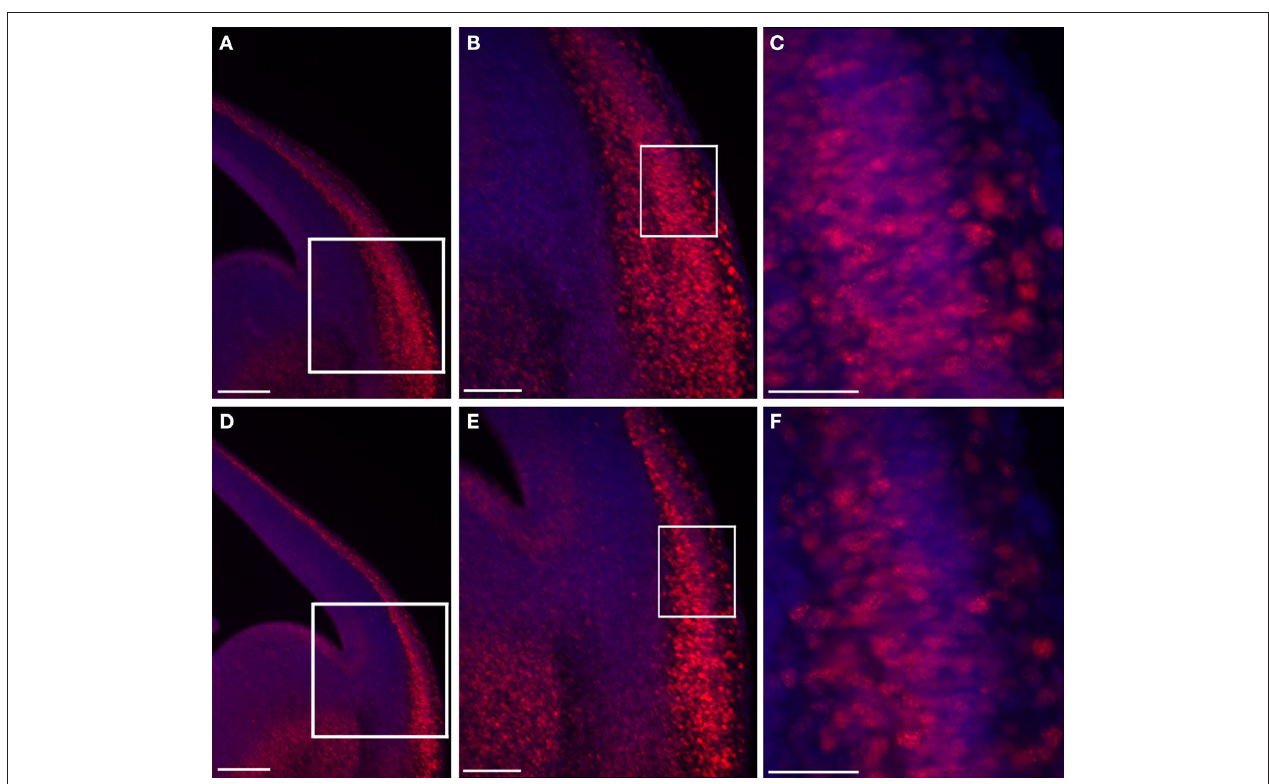
FIgure 5 | Double KO brain sections exhibit an increased area of nuclear β -catenin. Double KO (A–C) exhibit more cells with nuclear β -catenin in comparison with control (B–F) . The white boxes define the higher magnifications areas. Scale bars: (A,D) 200, (B,e) 100, (C,F) 40